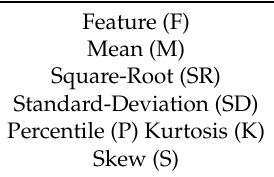
Table 2. Selected